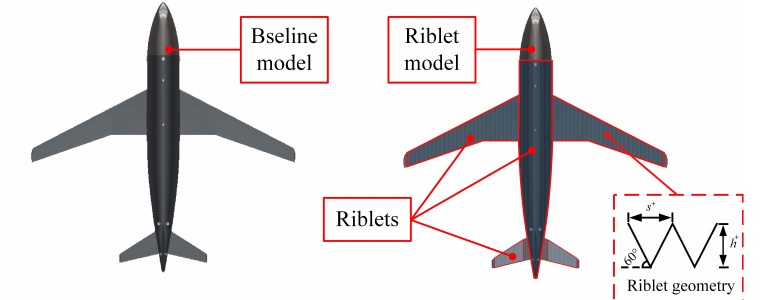
Figure 12. The baseline model and ribleted model of the wing–body